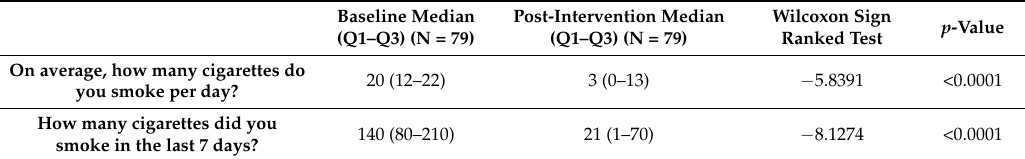
Table 7. Comparison for median for number of cigarettes per day and per weeks before and after Sehatack program (N =